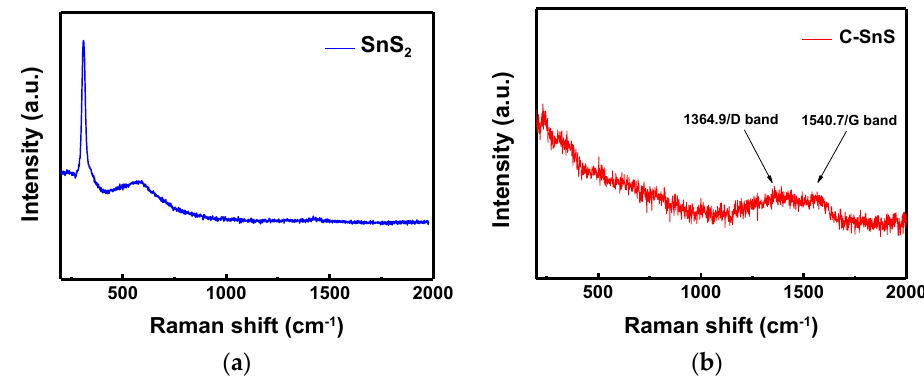
Figure 3. Raman spectrums of ( a ) SnS 2 and ( b ) carbon-coated SnS powders.